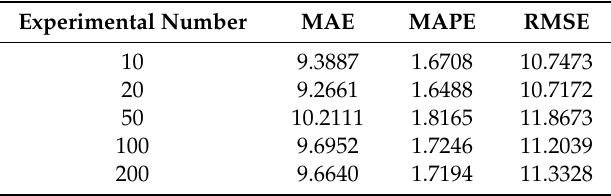
Figure 6. Evaluation metrics of ELM prediction using the first group of data. ( a ) Mean absolute error (MAE); ( b ) mean absolute percent error (MAPE); ( c ) root mean square error (RMSE). Table 2. Metrics of comparison experiments (Group 1).